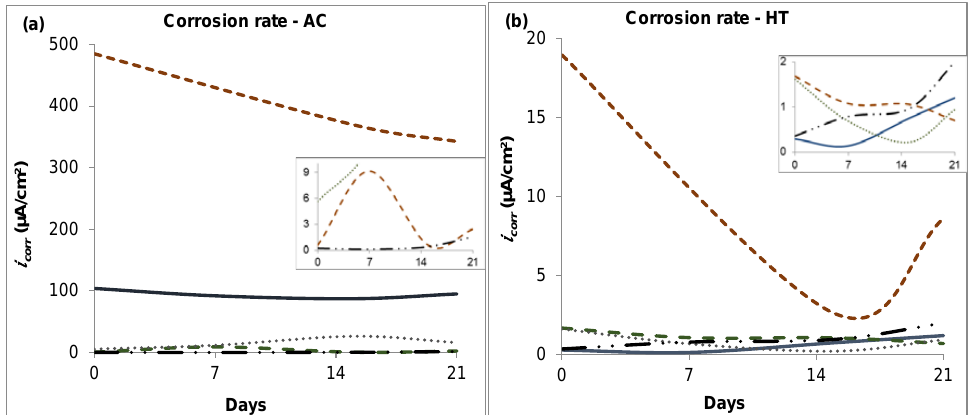
Figure 6. Evolution of the corrosion rates ( i corr ) with the immersion time under ( a ) as-cast and ( b ) heat treatment conditions; (—) 0B, (– –) 0.06B, ( ···· ) 0.25B, (- - - -) 0.5B, and (– · · ) 1B.